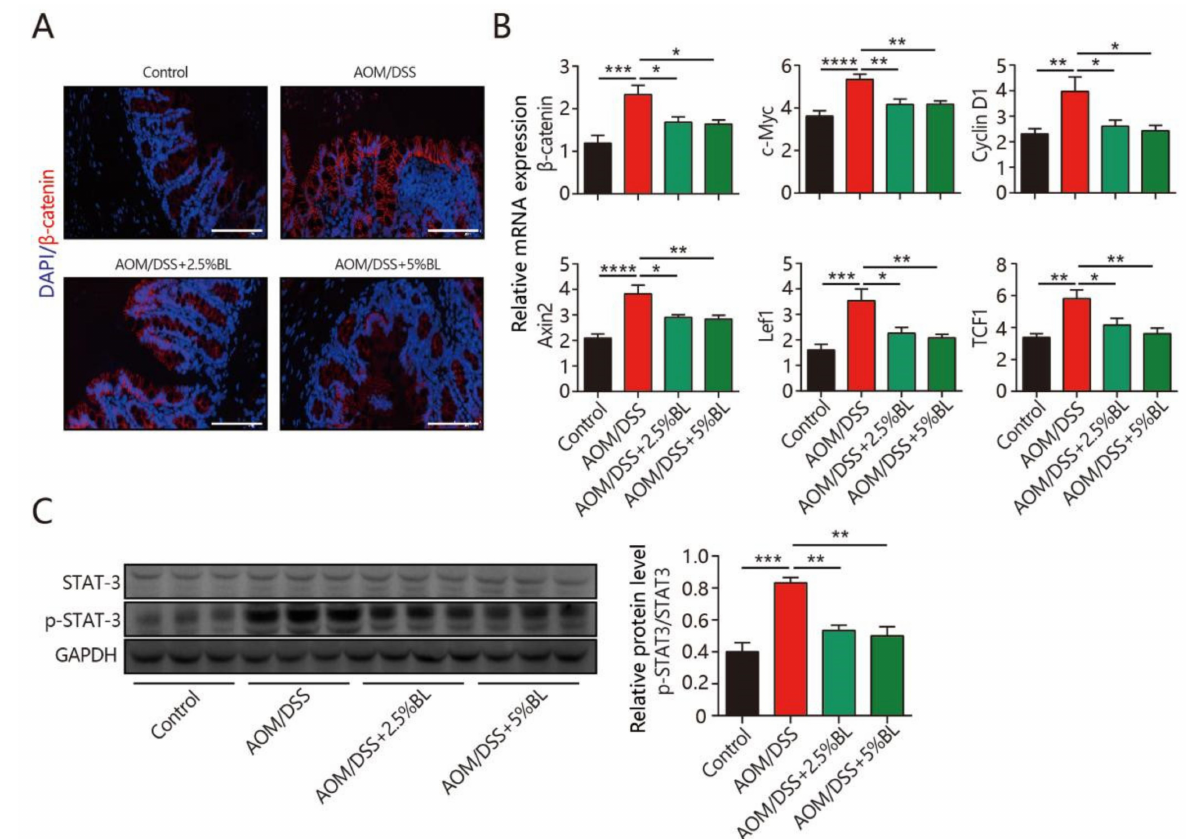
Figure 5. BL inhibits AOM/DSS-induced β -catenin signaling activation. ( A ) Immunofluorescent analysis of β -catenin (red) in mouse colonic sections (400 × ). ( B ) The expression of target genes in β -catenin signaling pathway and ( C ) protein levels of STAT3 and p-STAT3 in the colonic tissues were measured ( n = 8–10). Data are mean ± SEM. * p < 0.05, ** p < 0.01, *** p < 0.001, and **** p < 0.0001. The statistics were performed with one-way ANOVA. BL, barley leaf; AOM, azoxymethane; DSS, dextran sodium